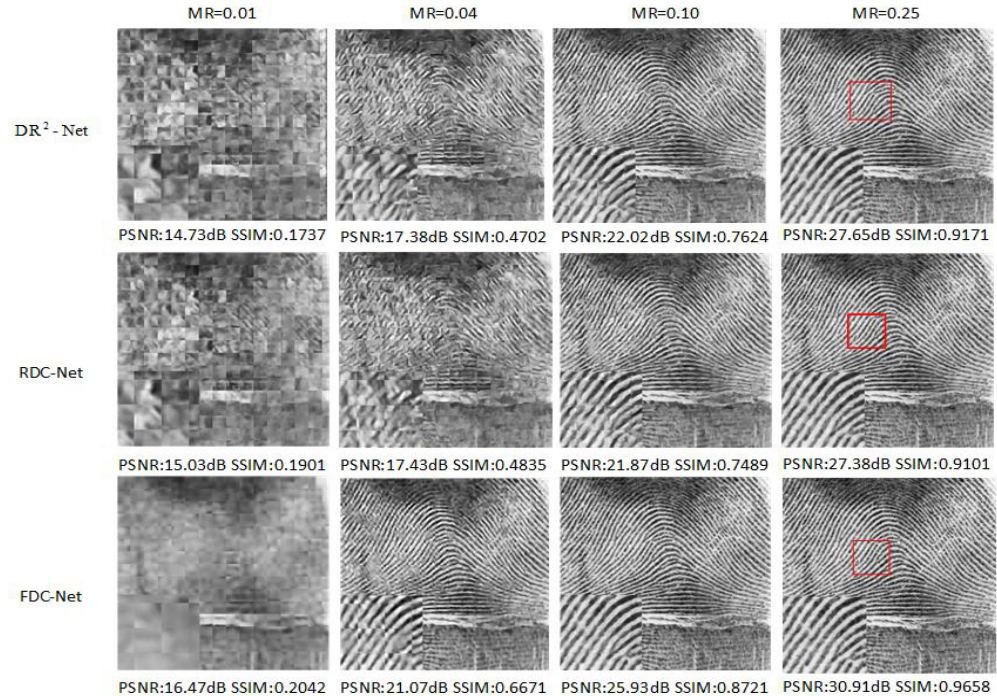
Figure 4. Fingerprint image reconstruction results from different networks. We can obviously find that two proposed networks obtain the excellent reconstruction performance and FDC-Net has better visual effects than RDC-Net, DR 2